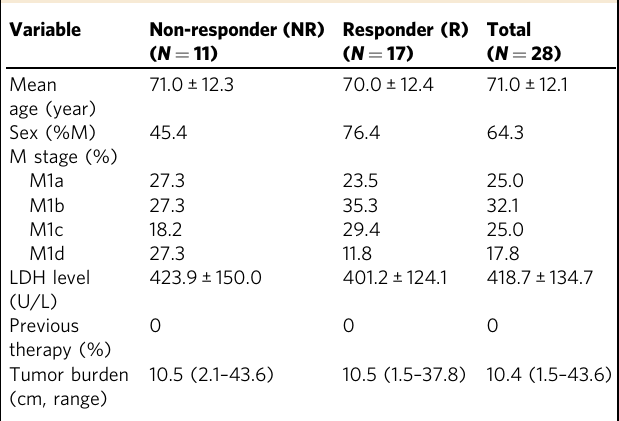
Table 1 Clinical characteristics of